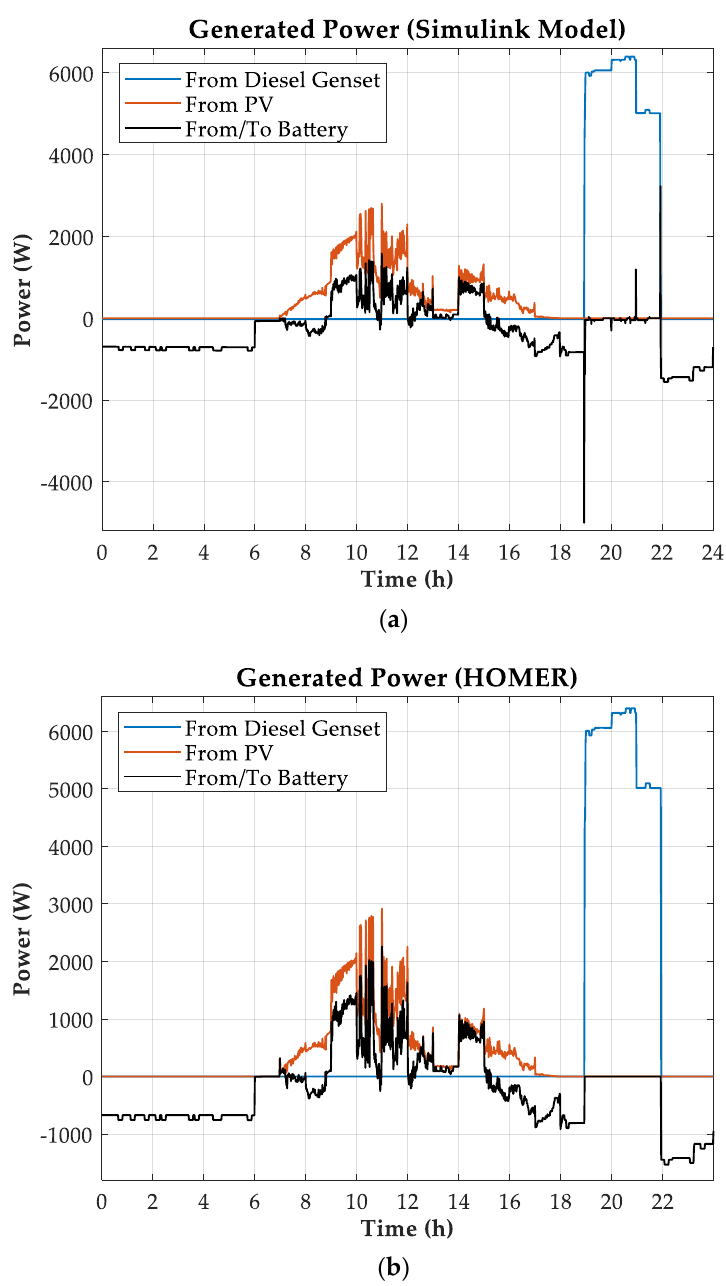
Figure 16. Electricity generation during winter solstice by component of the PV / diesel / battery system regarding ( a ) Simulink model and ( b ) HOMER simulation.